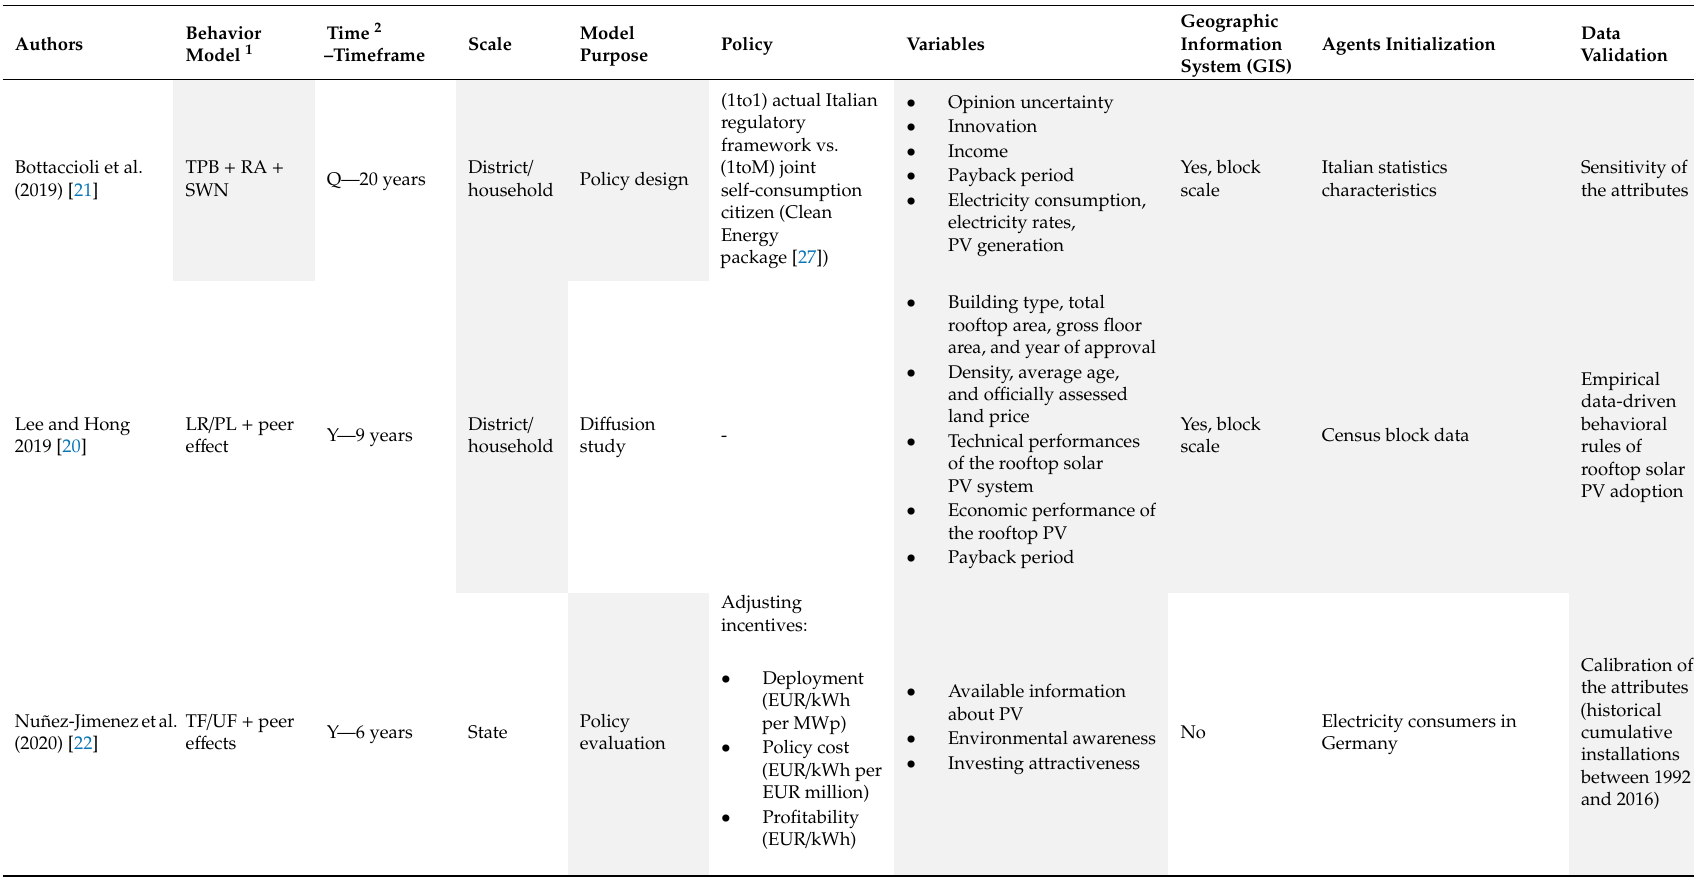
Table1. Mainreferencesonphotovoltaic(PV)di ff